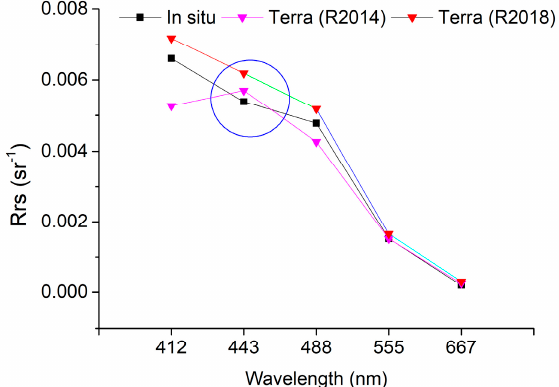
Figure 15. Example of direct spectral comparison between in situ measurement and satellite retrievals at a match-up site. In this case, MODIS-Terra (R2014) fails to retrieve the actual spectral shape of R rs ( λ ) and gets the lower QA score than MODIS-Terra (R2018), although its agreement with in situ data at all bands except for 412 nm band is good.